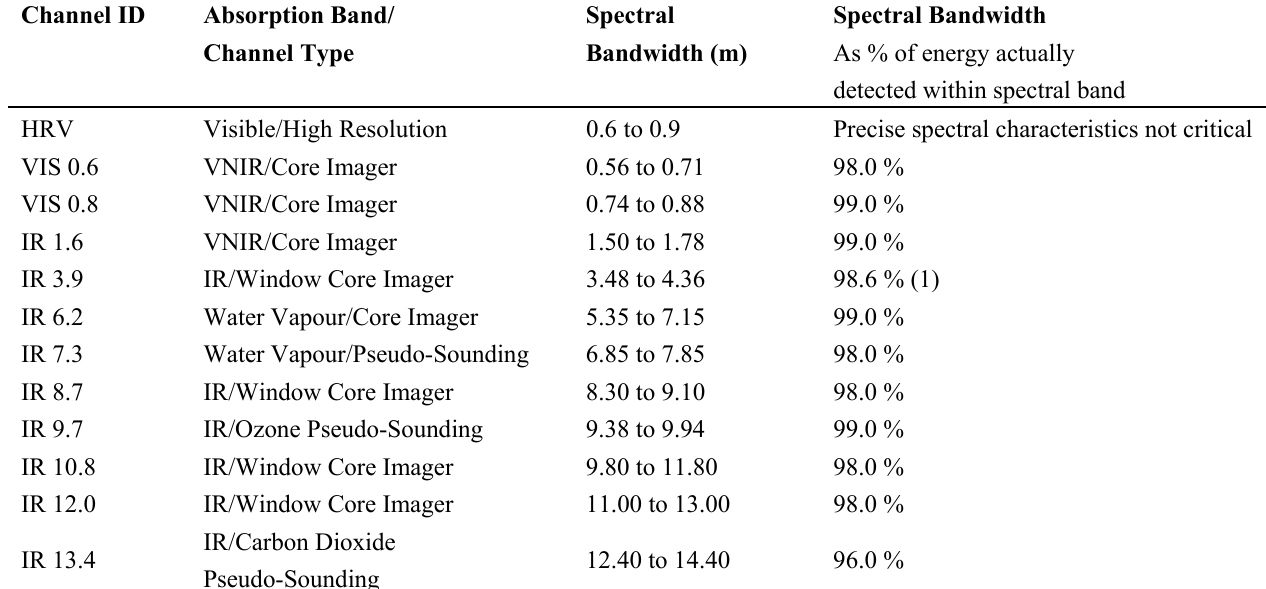
Table 1. SEVIRI channel characteristics [12].